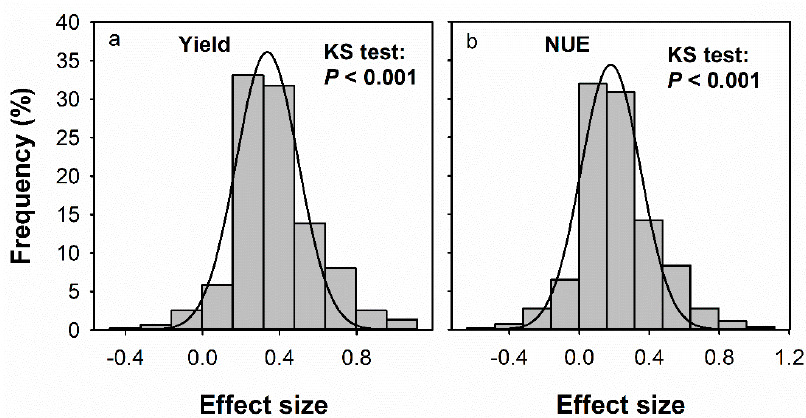
Figure 2. Frequency distribution of effect size for potato yield ( a ) and nitrogen use efficiency (NUE) ( b ) response to mulching compared to without mulching. Solid lines are fitted to a Gaussian distribution function. The Kolmogorov–Smirnov (KS) test indicated that the distribution of yield and NUE was not normal ( p < 0.001).